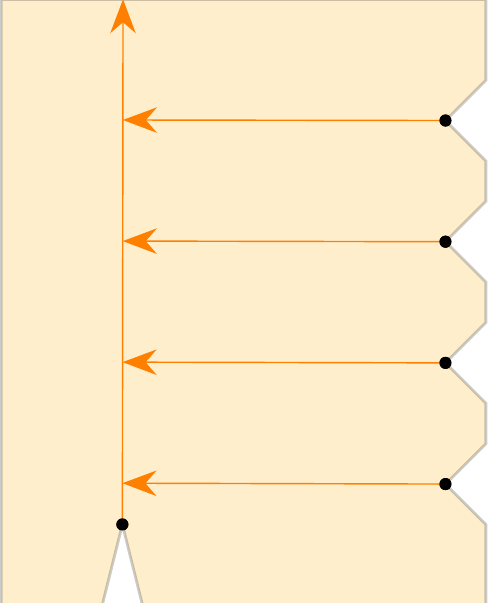
Figure 7. The insertion of one motorcycle can block all the others.